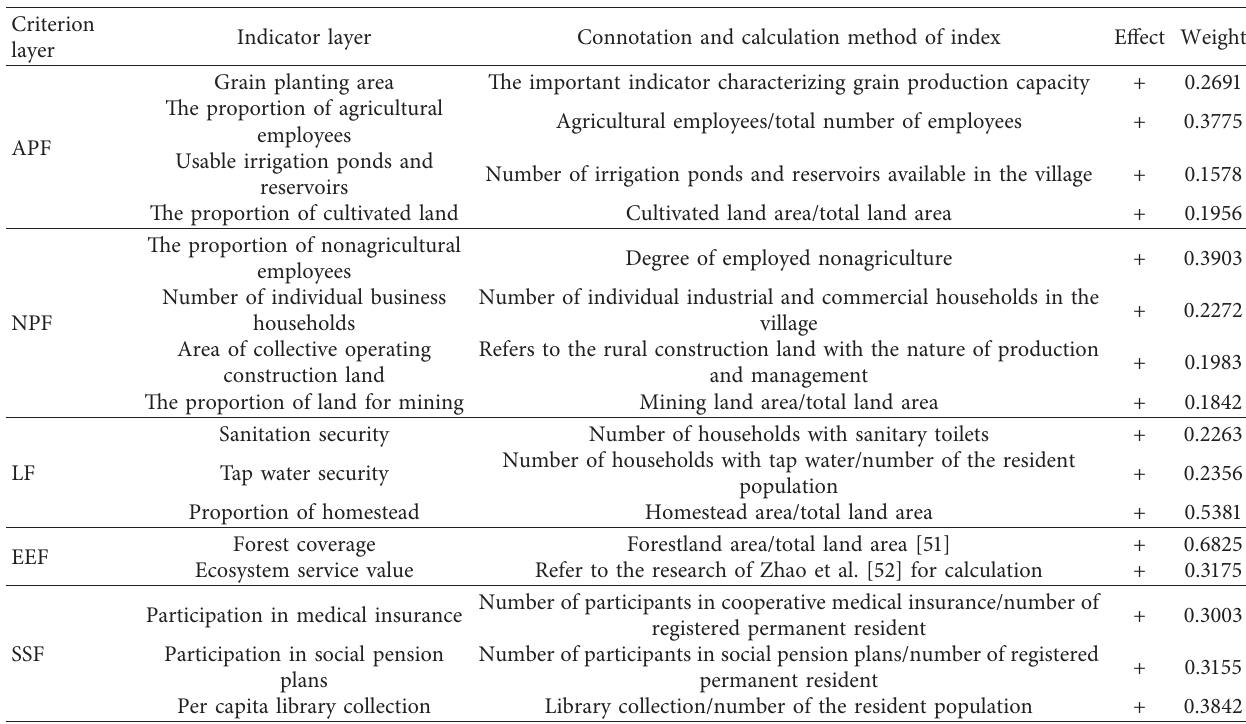
Table 1: Evaluation index system for rural multifunction.